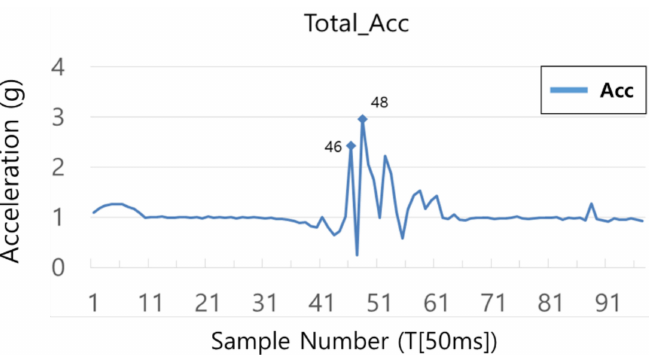
Figure 9. The accident occurred in the 46T–48T section. Most of the acceleration values are between − 2 g and 2 g, and the angle values are between − 180 and 180 deg. The acceleration was divided by 2, and the angle was divided by 180 so that the values of the input data were almost between − 1 and 1. The number of cells was 15. Six input data were inputted per cell, and nodes amounted to 48. The output of LSTM was entered as the input of NN and finally outputted via NN. Figure 10 shows the structure of LSTM in this paper. The NN received the output of LSTM as an input, proceeded through 4 hidden layers to reduce to 90, 30, 15, 8, and then obtained the final output. An activation function was used for each layer. The 1st, 3rd, and 4th hidden layers used tanh functions, and the 2nd hidden layer used ELU functions. The last output layer used sigmoid functions to classify the output into a binary. This was to distinguish between the accident and the non-accident by 1 and 0, respectively. Dropout was used to prevent overfitting. Cross entropy was used as a loss function and the adaptive moment estimation (ADAM) is used as an optimization algorithm to help learn inertially, but also adjustably according to the state of the parameters